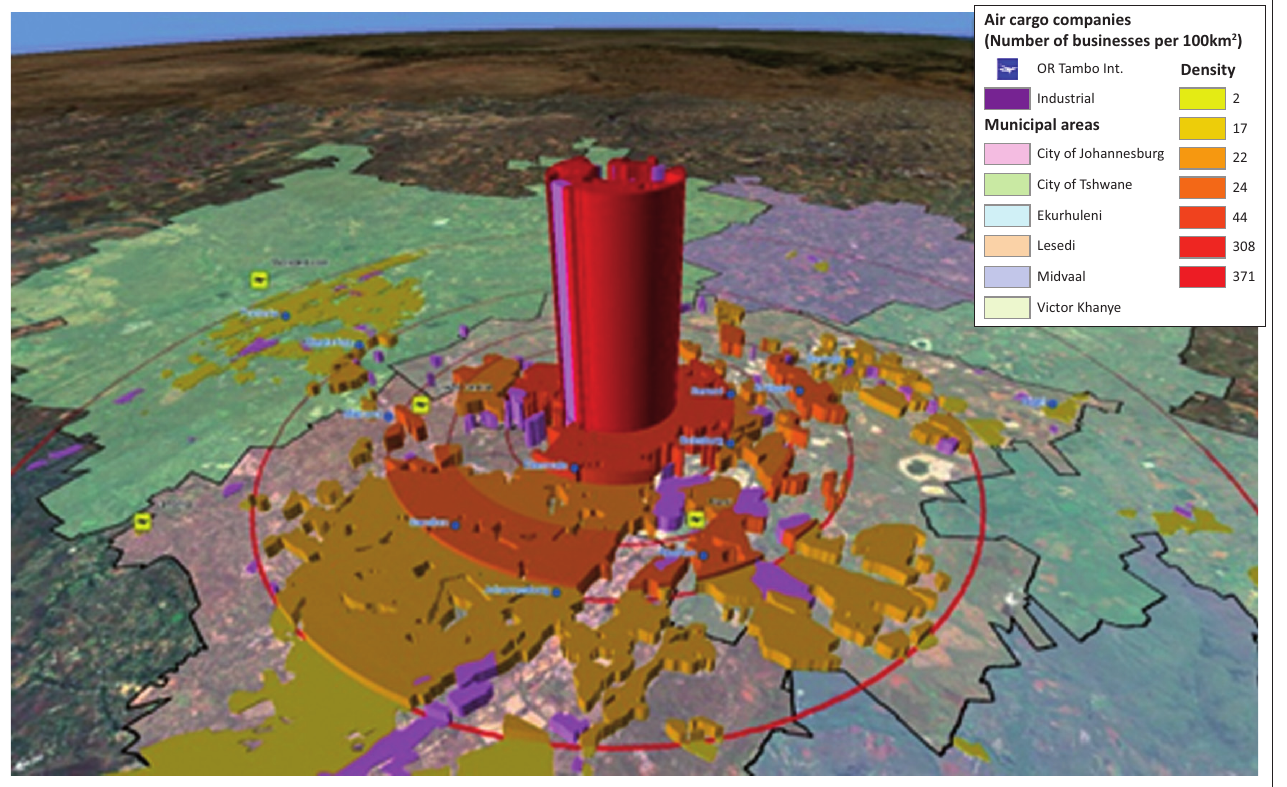
FIGURE 3: Density of air cargo